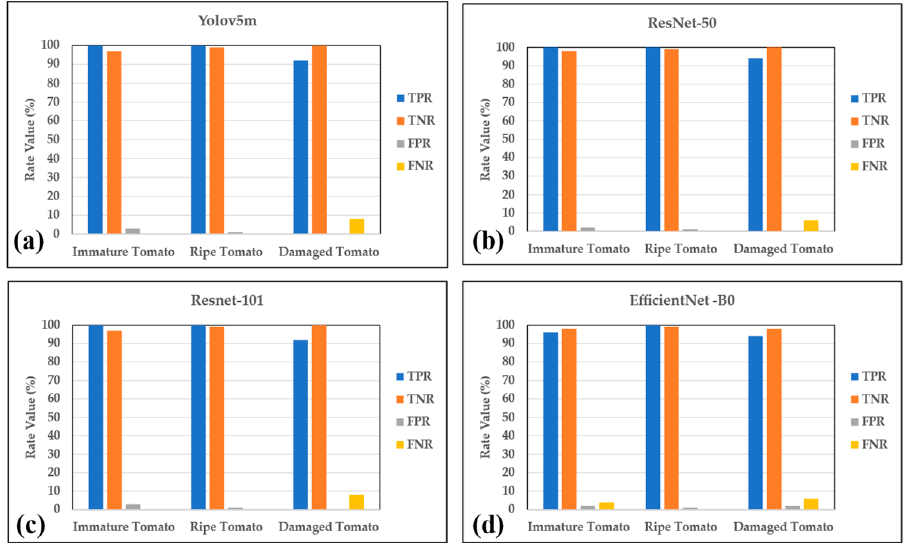
Figure 4. TPR, TNR, FPR, and FNR values of ( a ) Yolov5m, ( b ) Resnet-50, ( c ) Resnet-101, and ( d ) EfficientNet-B0 models.